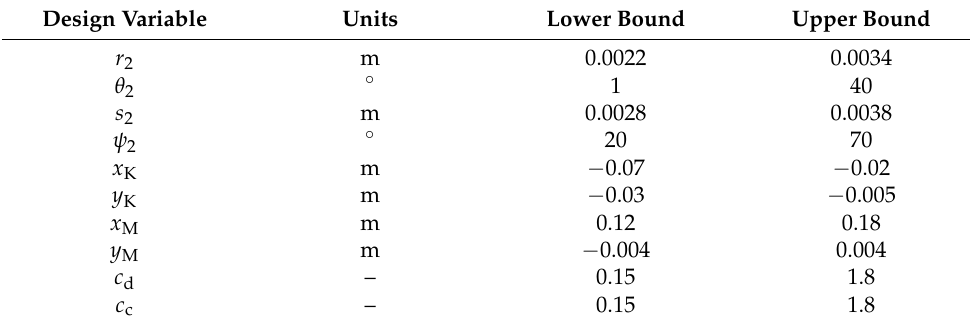
Table 1. Design variables with their bounds.